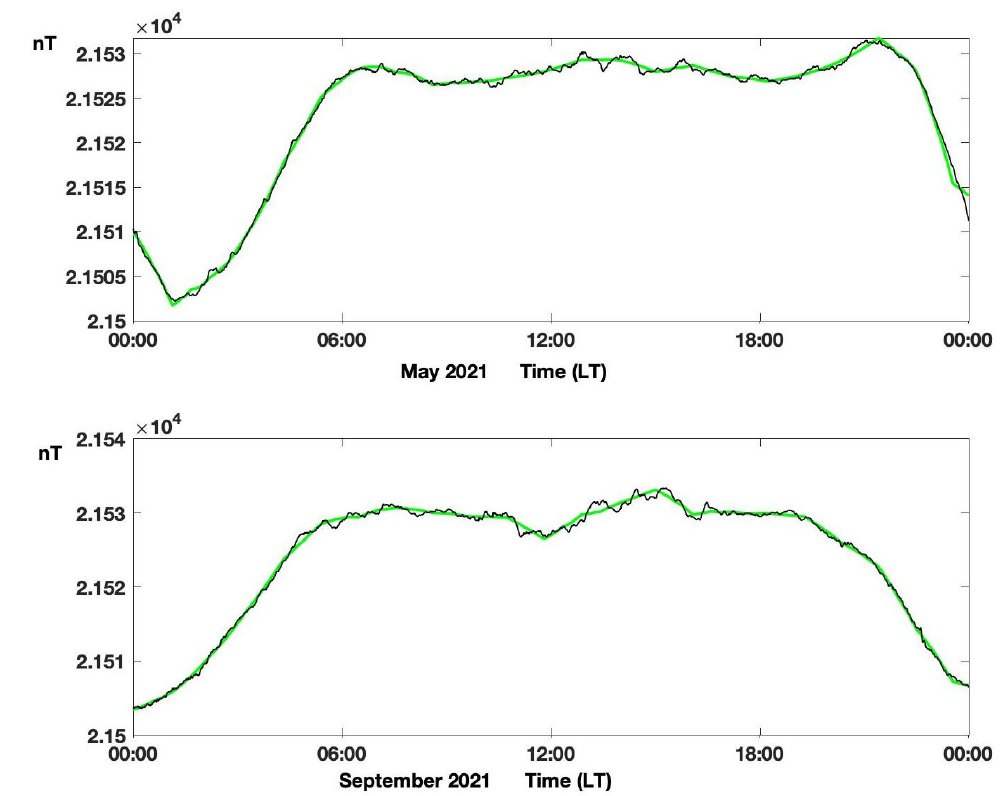
Figure 5. Processing results for D-component variations on 5 December, 2017. ( a ) D-component, noisy; ( d ) D-component, cleared; ( b , c , e , f ) results of method